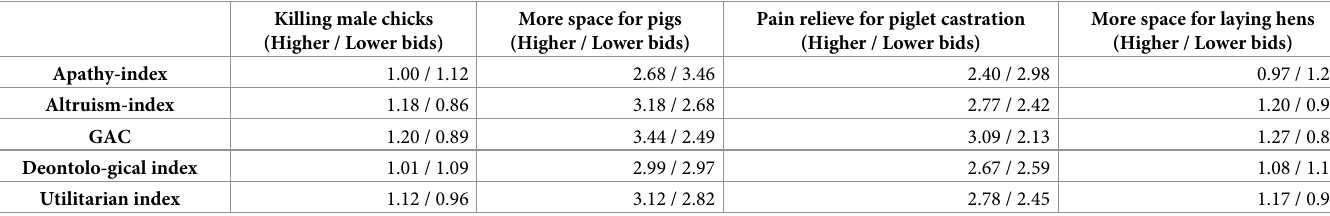
Table 4. WTP mean in Euro per group in relation to moral scales (sample split in two groups, total n = 1334). Killing male chicks More space for pigs Pain relieve for piglet castration (Higher / Lower bids) (Higher / Lower bids) (Higher / Lower bids)